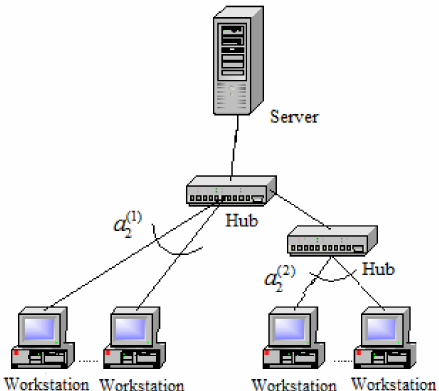
Figure 1. An example of technical equipment of a local area computer